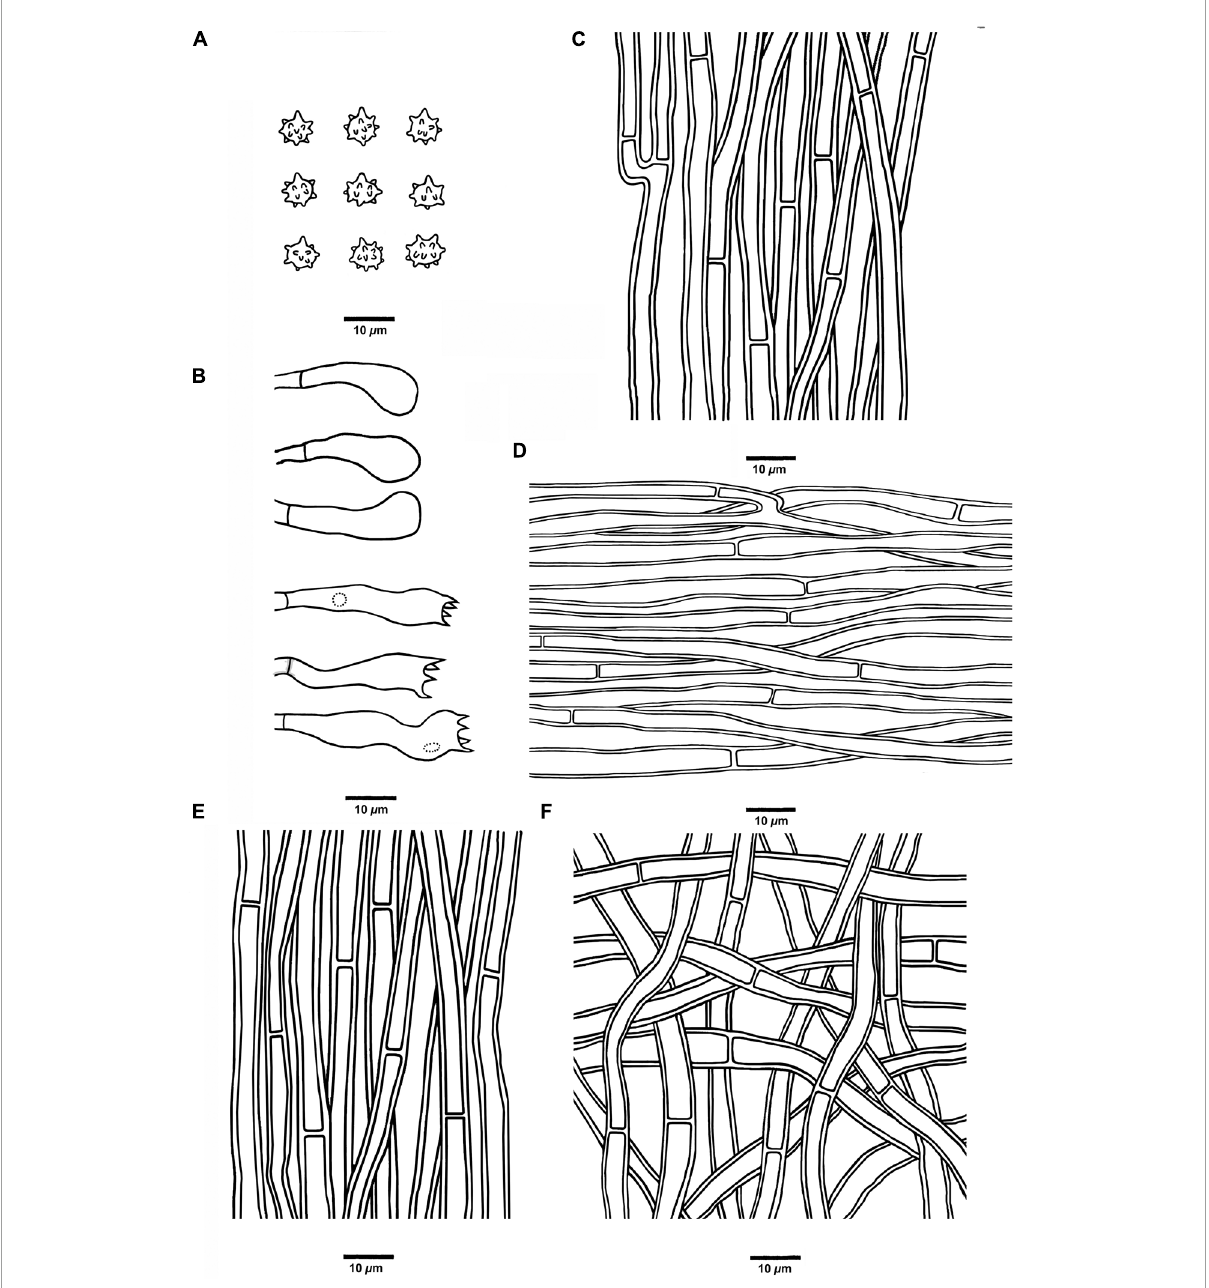
FIGURE7 Microscopic structures of H. crassipileatum (drawn from Cui 17021). (A) Basidiospores, (B) Basidia and basidioles, (C) Hyphae from context, (D) Hyphae from spines, (E) Hyphae from the inner layer of stipe, and (F) Hyphae from the surface layer of stipe.